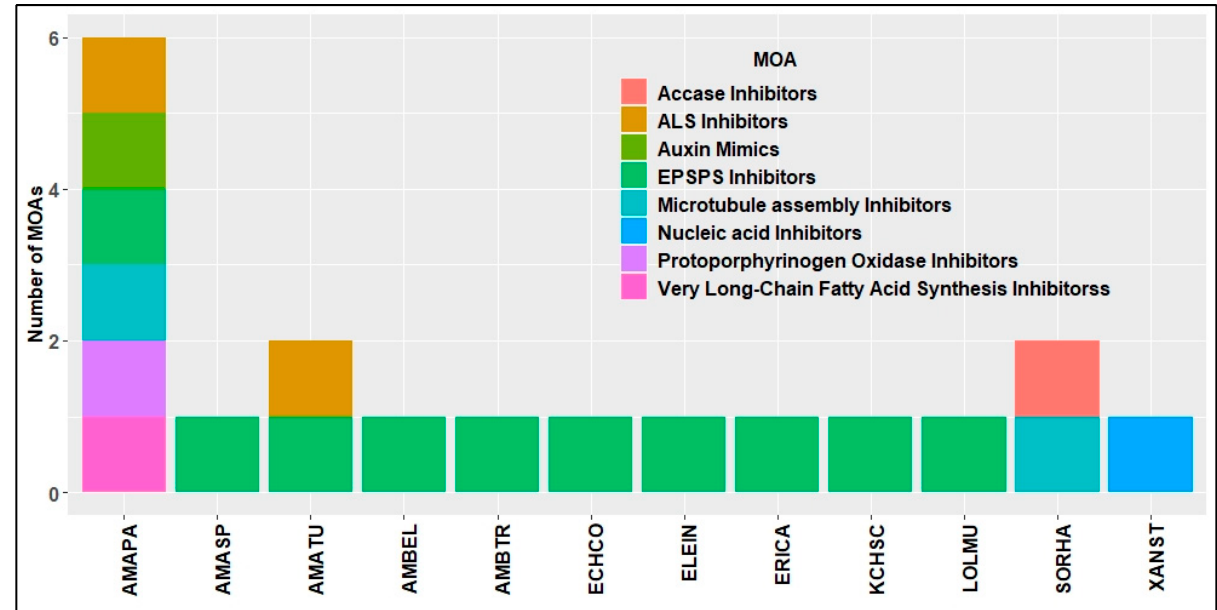
Figure 5. Weed species resistant to different MOAs in the U.S. cotton production systems [24] .